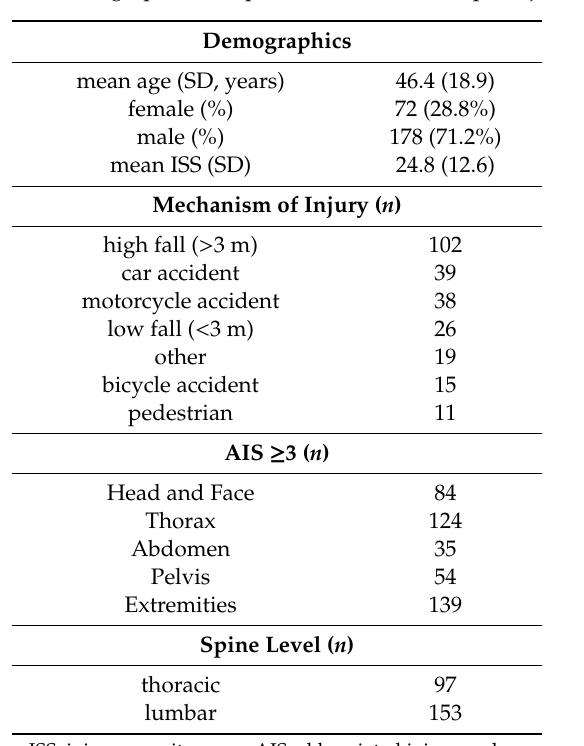
Table 1. Baseline demographics for spinal fractures in multiple-injured